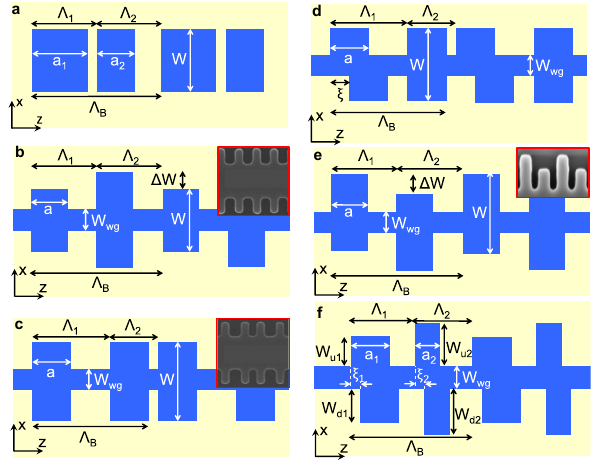
Figure 14: SWG-based Bragg filter geometries. The Bragg period Λ B isdividedintwoslightlydifferentsubwavelengthsubperiods: Λ 1 and Λ − Λ Λ 2 = B 1